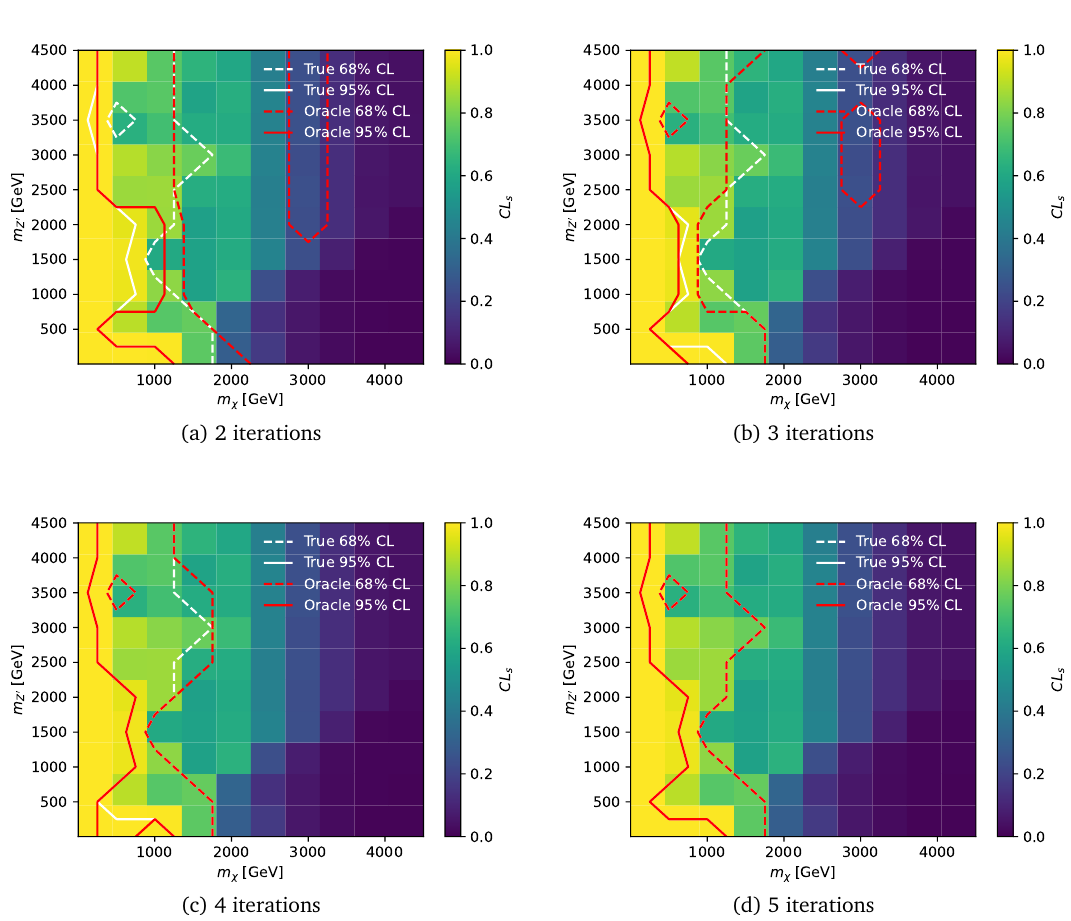
Figure 6: Comparison of the 95% (solid lines) and 68% (dashed lines) exclusion con- tours from the brute-force C ONTUR scan (in white) and from the O RACLE predictions (in red) for 2-5 iterations, for a slice of the four-dimensional grid of parameter points for the = 0.15. In this slice, after five iterations simplified DM model where g χ = 0.65 and g q (or less than 20% of the total grid), the O RACLE reproduces the standard C ONTUR results